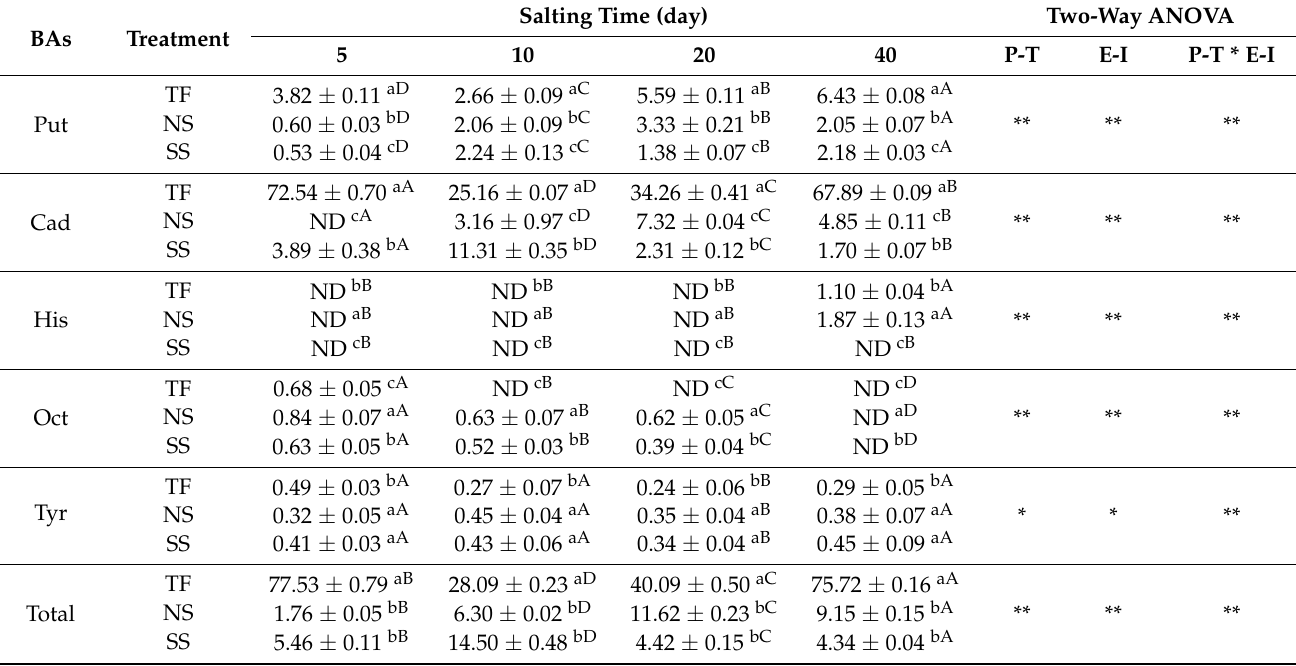
Table 1. Biogenic amine contents of salted herring in different salting stages (mg/kg).